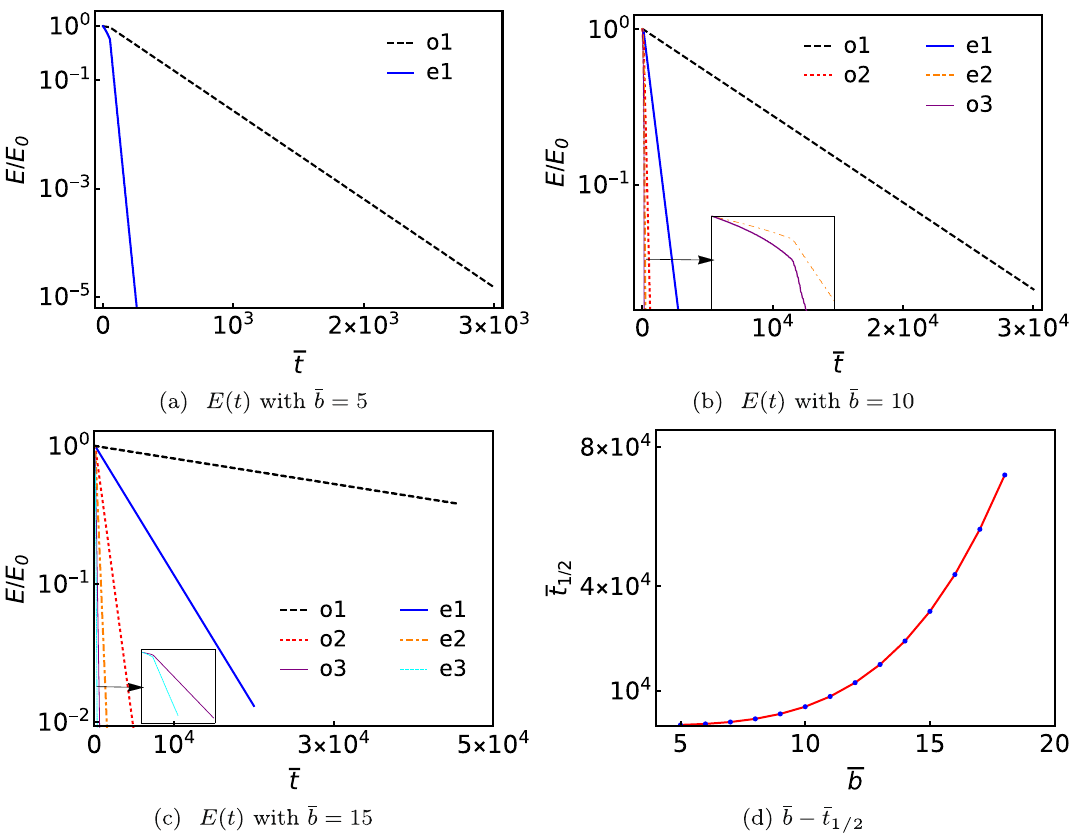
Fig. 3 a – c The energy of the scalar field vs. time for the evolution of the resonant modes for different values of the parameter ¯ b . Here, o1 represents thefirstodd-parityresonance,e1representsthefirsteven-parityresonance,andsoon. d Therelationbetweenthehalf-lifeofthefirstscalarresonance and the parameter ¯ b